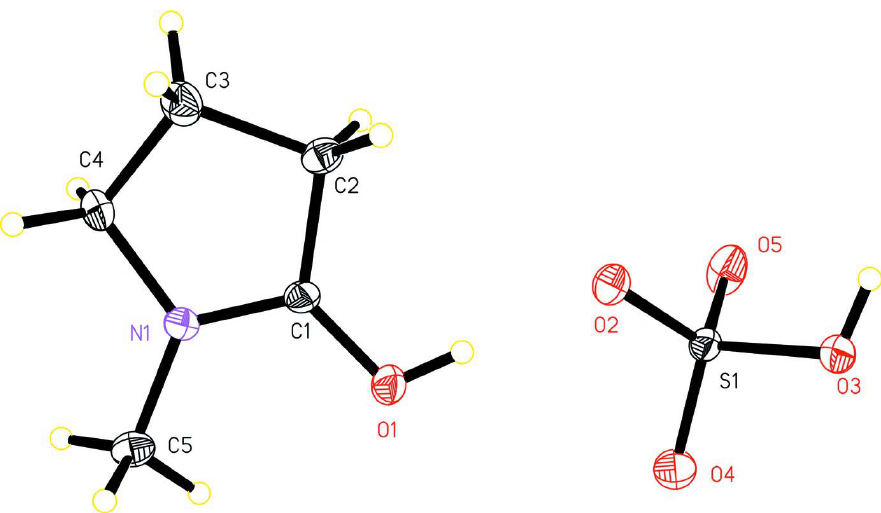
Figure 1 The molecules in the asymmetric unit of the title compound, with anisotropic displacement parameters drawn at the 50% probability